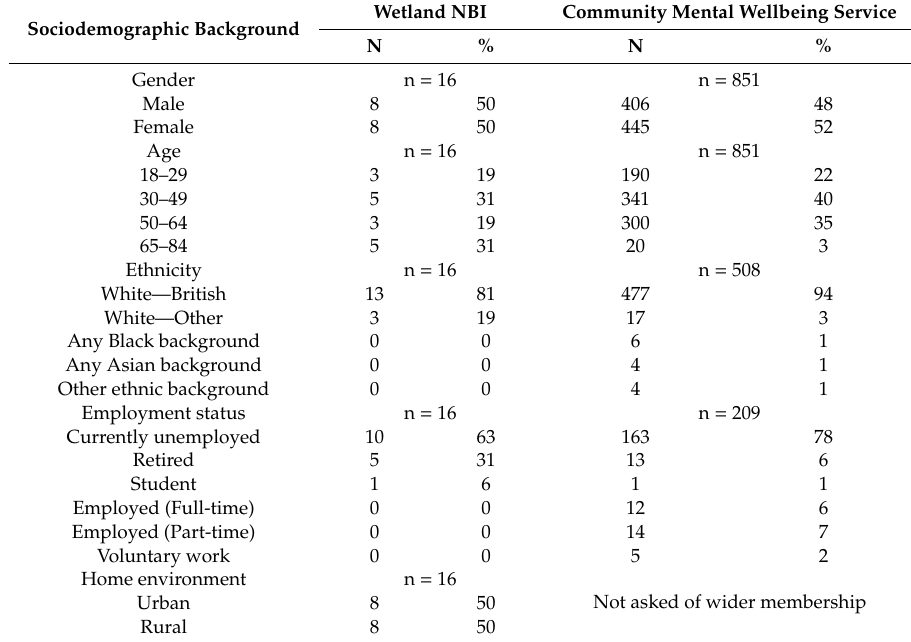
Table 1. Sociodemographic background of participants who took part in the wetland nature-based health intervention (NBI) (n = 16) in comparison to the wider community mental wellbeing service membership (n =